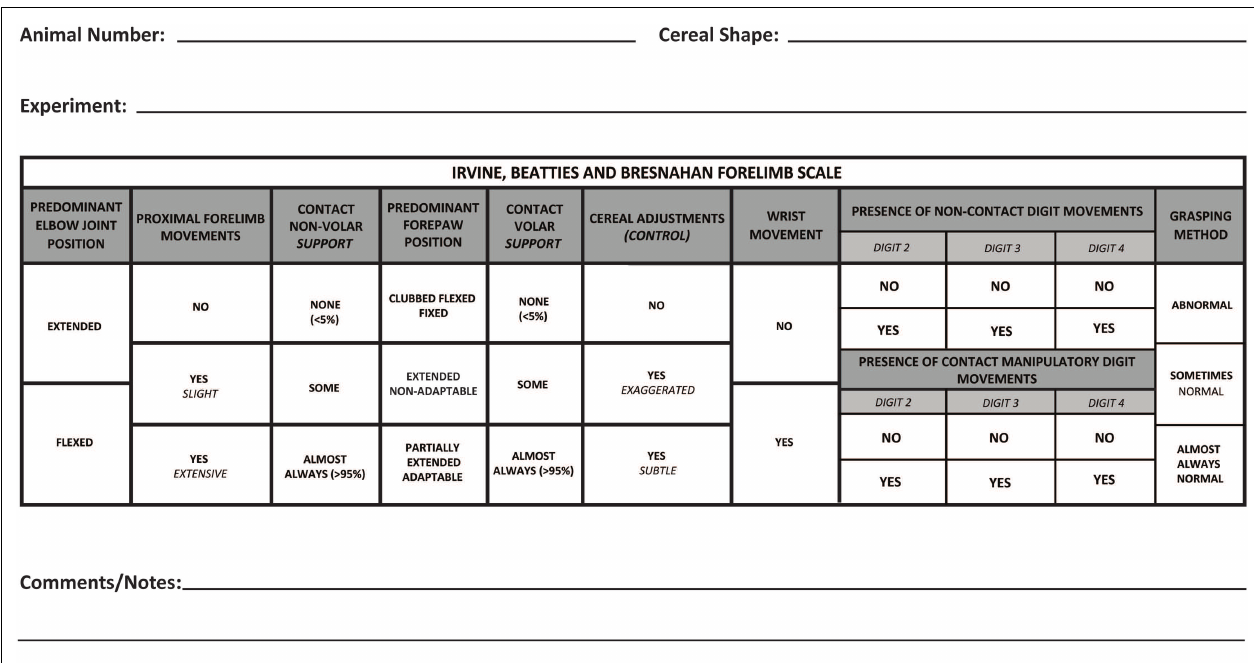
FIGURE 1 |The revised scoring sheet with individual categories that accompanies the Irvine, Beatties, and Bresnahan (IBB) forelimb scale .The first half of the sheet represents recovery of proximal forelimb function and the latter part of the sheet focuses on recovery of the forepaw.